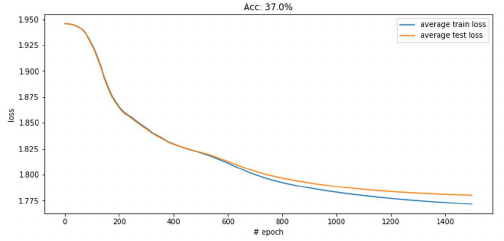
Figure 3. Loss evolution over 1,500